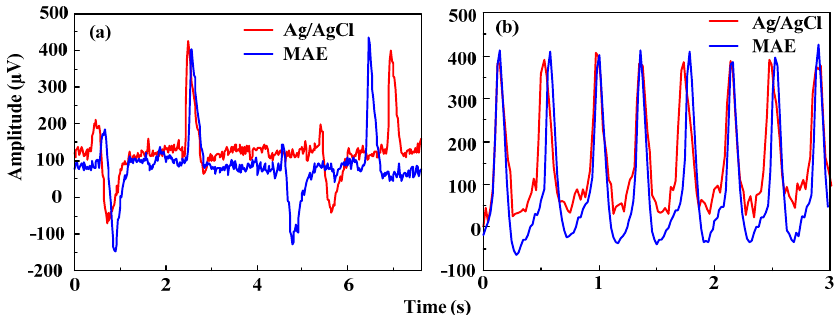
Figure 10. ECG signals recorded: ( a ) in the static state, and ( b ) in the dynamic